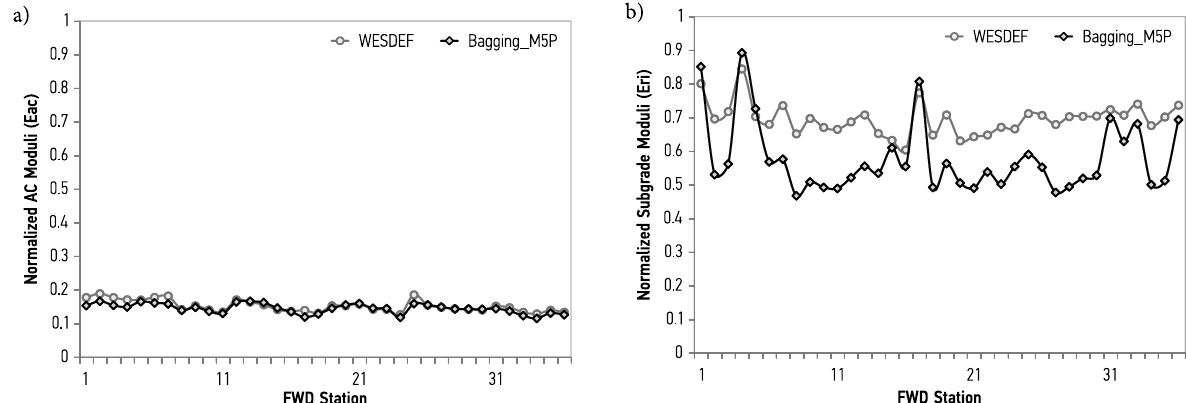
Fig. 9. Asphalt pavement moduli predictions with Bagging_M5P using actual FWD deflections basins acquired in the field: a – E ac ; b – E